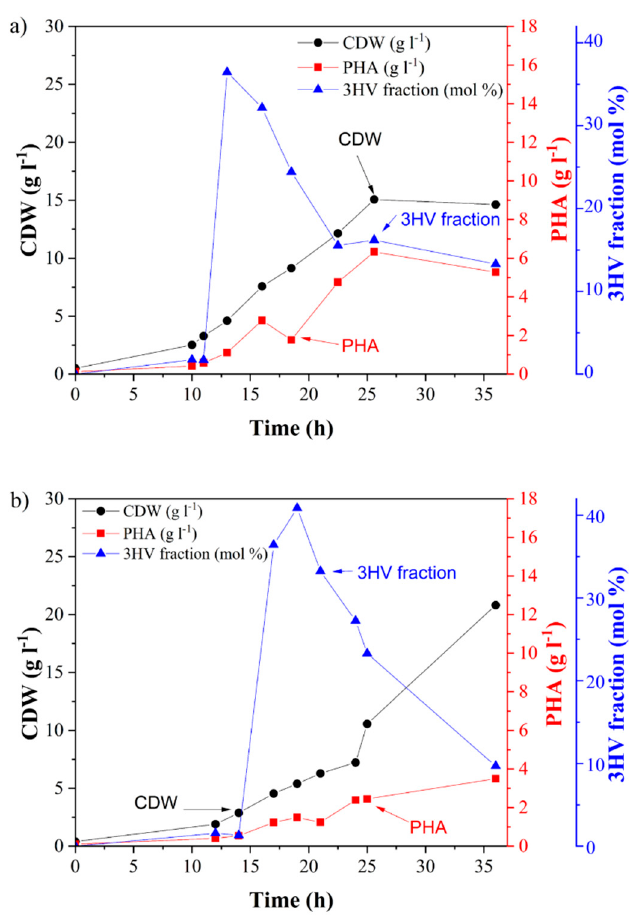
Figure 1. Growth and production characteristics of Cupriavidus necator grown on ( a ) fructose and ( b ) grape sugar extract. Table 1. Cultivation of C. necator and poly(3-hydroxybutyrate-co-3-hydroxyvalerate) (PHBV) after 36